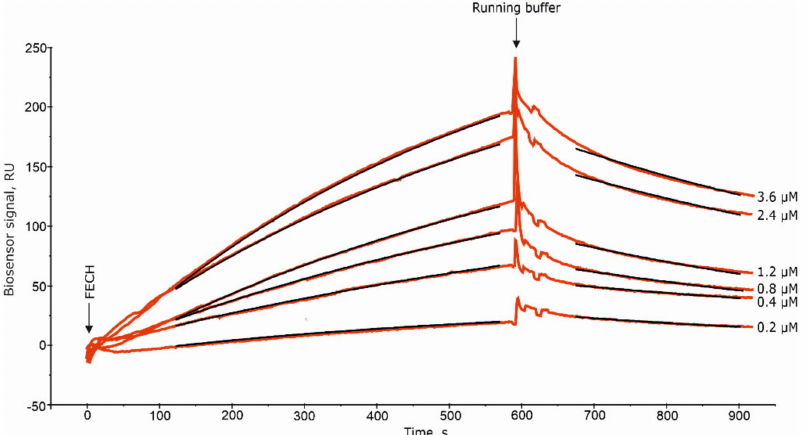
Figure 1. ( A ) Typical surface plasmon resonance (SPR) binding between immobilized ferrochelatase monomer on the optical chip and di ff erent concentration of adrenodoxine reductase (ADR): 0.1 µ M (1), 0.5 µ M (2), 1 µ M (3), 2.5 µ M (4), 5 µ M (5). Fitting curves (theoretical models) are highlighted in black; Chi 2 values are equal to 10.5 and 0.5 RU for association and dissociation phase, respectively. Complex dissociation constant (K d ) values were calculated as ratio: K d = k o ff / k on . ( B ) Binding levels of ferrochelatase (FECH) or ADR used as analytes with immobilized monomer (dimer) form of FECH protein. All analytes were injected at a concentration of 5 µ M through biosensor channels for 10 min at a flow rate of 10 µ L / min. Data represent mean ± SD, n = 3.